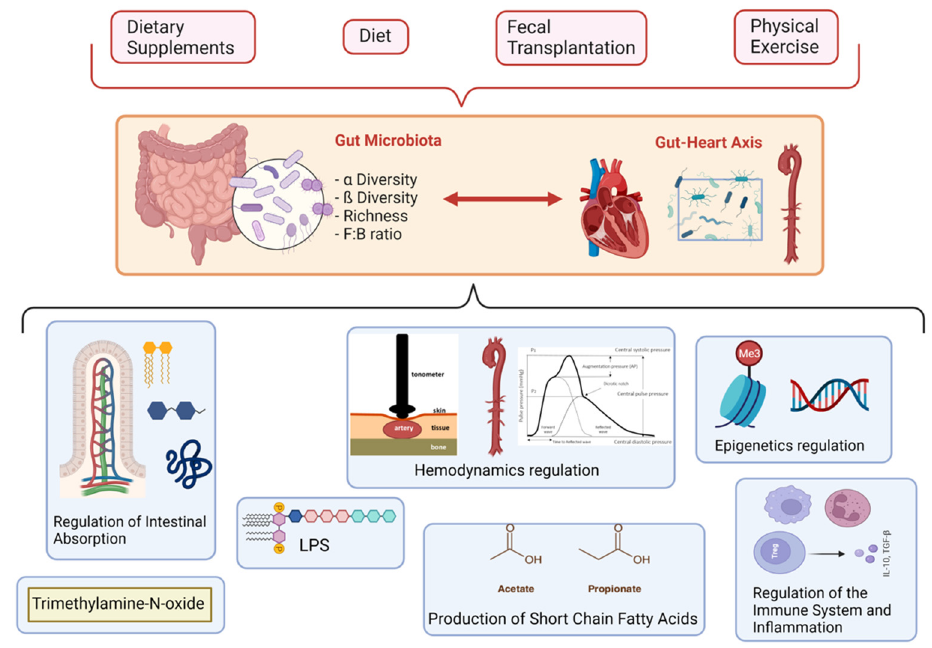
Figure 1. Schemes of the intercorrelation between environmental and biological mechanisms, gut microbiota, and vascular ageing.